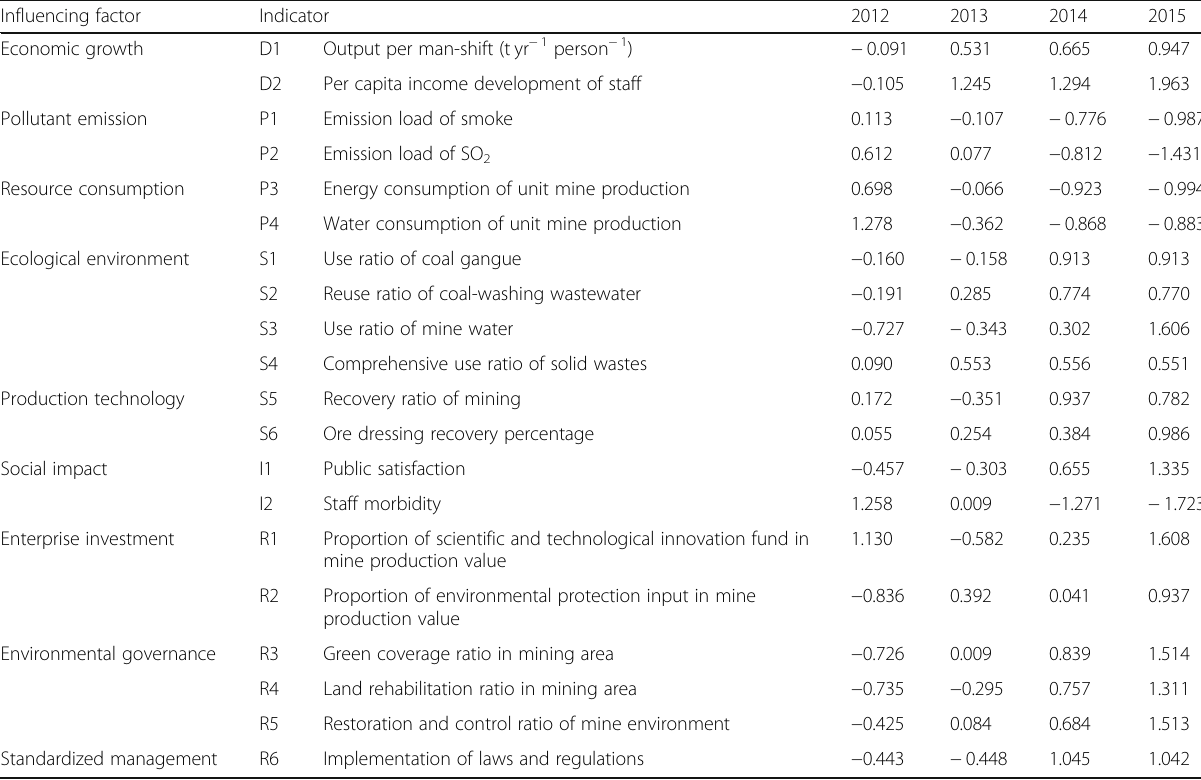
Table 3 Standardized data of each indicator